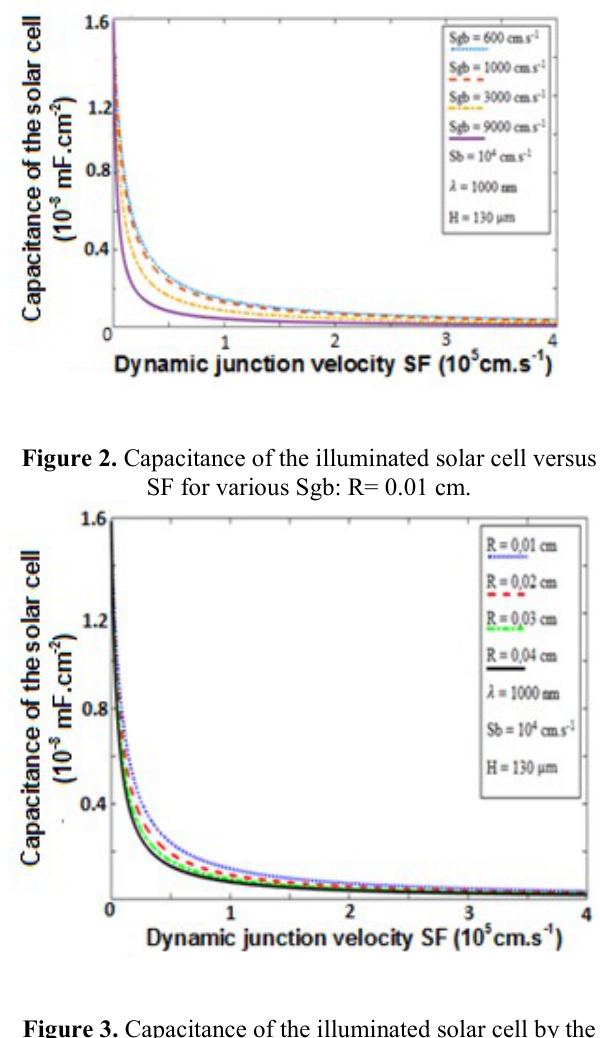
Figure 3. Capacitance of the illuminated solar cell by the front surface versus SF for various radius (R): L = 0.01 cm